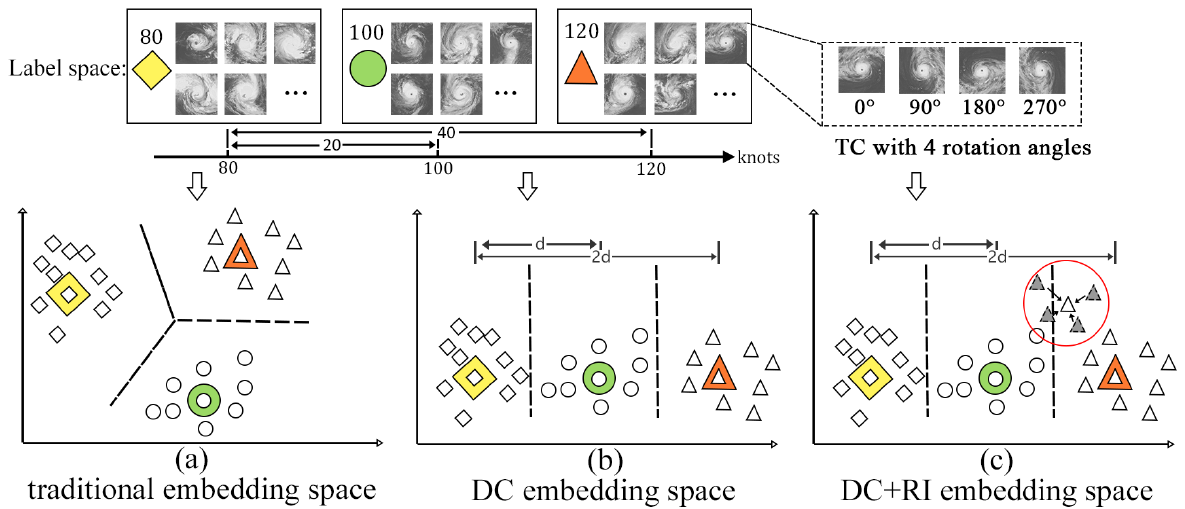
Figure 1. Comparison between typical method and ours. Compared with ( a ), the DC embedding space ( b ) is more consistent in terms of feature and distance. In the red circle of ( c ), RI embedding space can help the same tropical cyclone with different angles to reach a more accurate